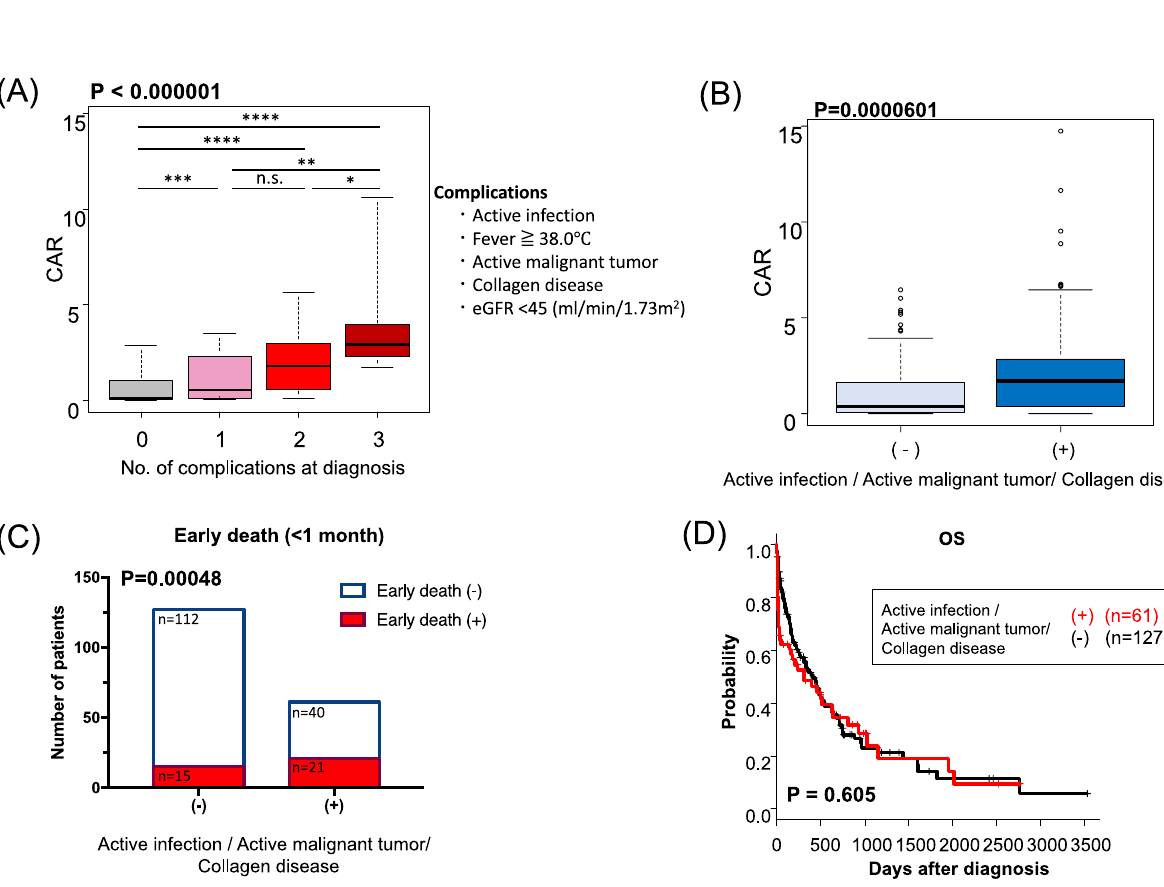
Figure 4. ( A ) Distribution of CAR in patients without complications (n = 63) and 1 complication (n = 76), 2 complications (n = 34), 3 complications (n = 15) at diagnosis. ( B ) Distribution of CAR in patients with (n = 61) or without (n = 127) active infection and/or active malignant tumor and/or collagen disease at diagnosis. ( C ) The number of patients died within 1 month from diagnosis in patient groups with/without active infection and/or active malignant tumor and/or collagen disease at diagnosis. ( D ) Kaplan–Meier plots of OS according to patient groups with/without active infection and/or active malignant tumor and/or collagen disease at diagnosis (*P < 0.05; **P < 0.01; ***P < 0.005; ****P < 0.001, n.s., not